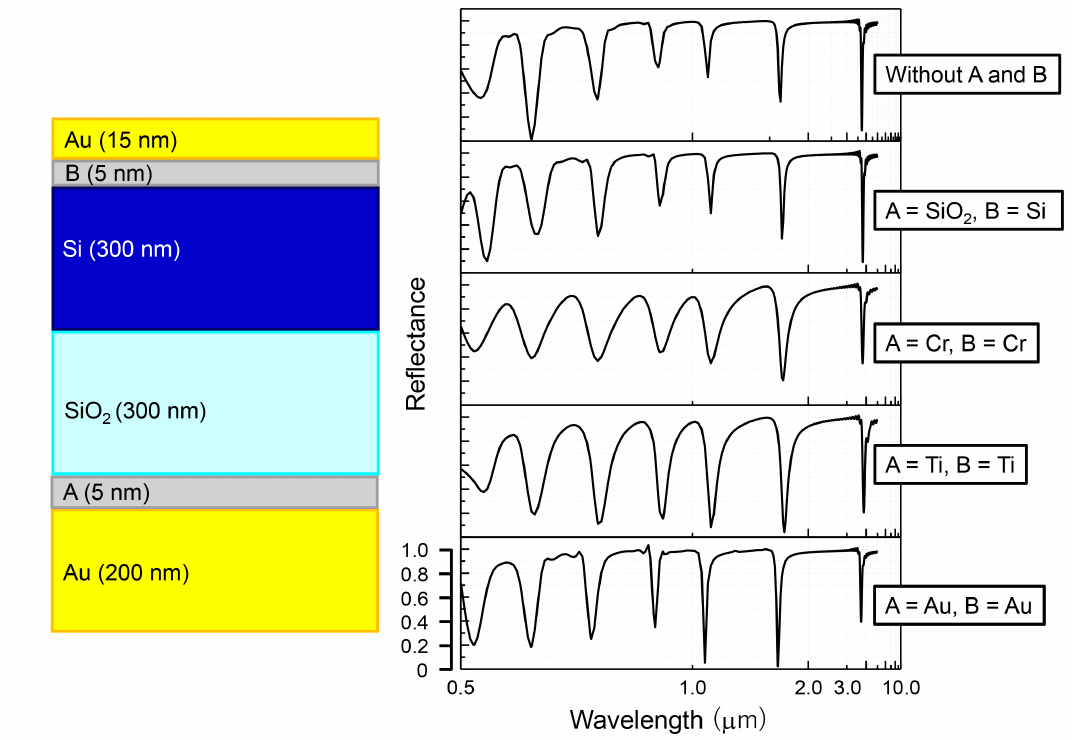
Figure 6. Influence of adhesion layers estimated by way of FDTD simulations. Sketch on the left shows the model structure, where A and B represent the additional adhesion promoting layers. Plots on the right give the simulated reflectance spectra with various configurations and metals applied for these